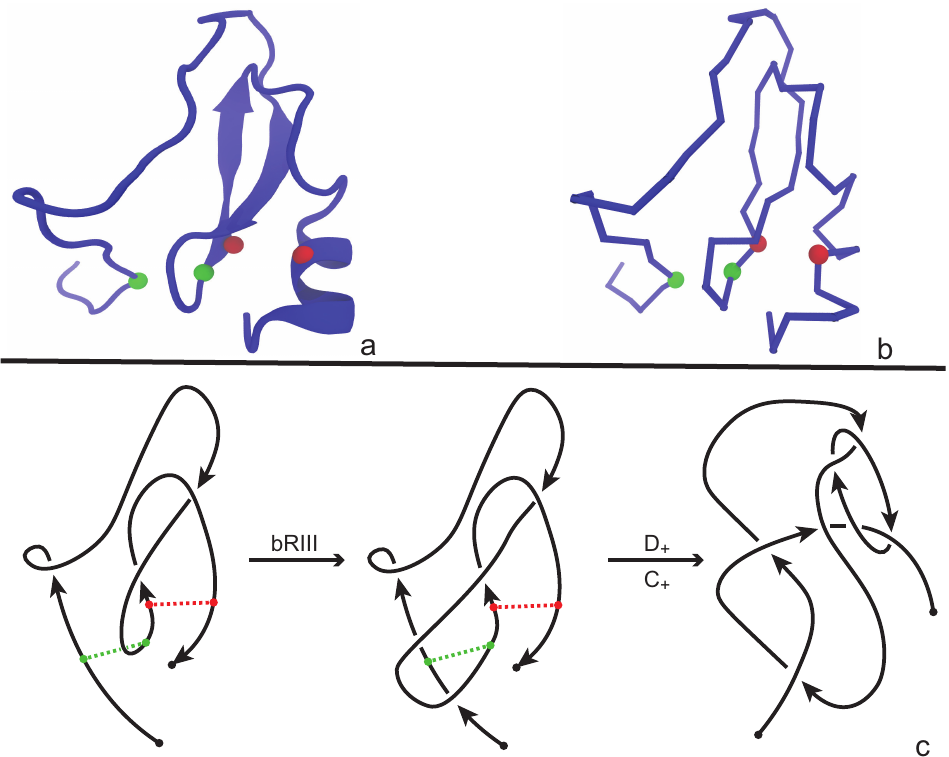
Figure 8. The protein 2LFK as ( a ) a cartoon; and ( b ) a polygonal curve. Same colored spheres indicate that there is a bond between them. More precisely, the green dots correspond to the pair of residues with indices 24 and 51, while the red to the pair 52 and 69. Below ( c ) is the corresponding bonded knotoid diagram and the appropriate substitutions. In the diagram the bonds are represented by colored dashed